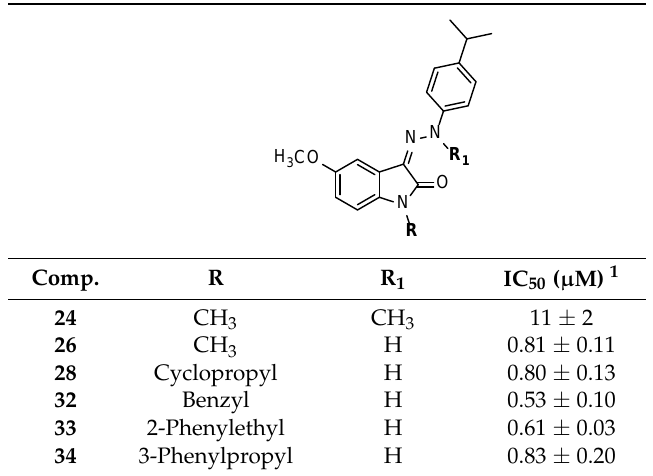
Molecules 2018 , 23 , x Table 4. A β Antiaggregating Activity of Compounds 24 , 26 , 28 and 32 – 34 .